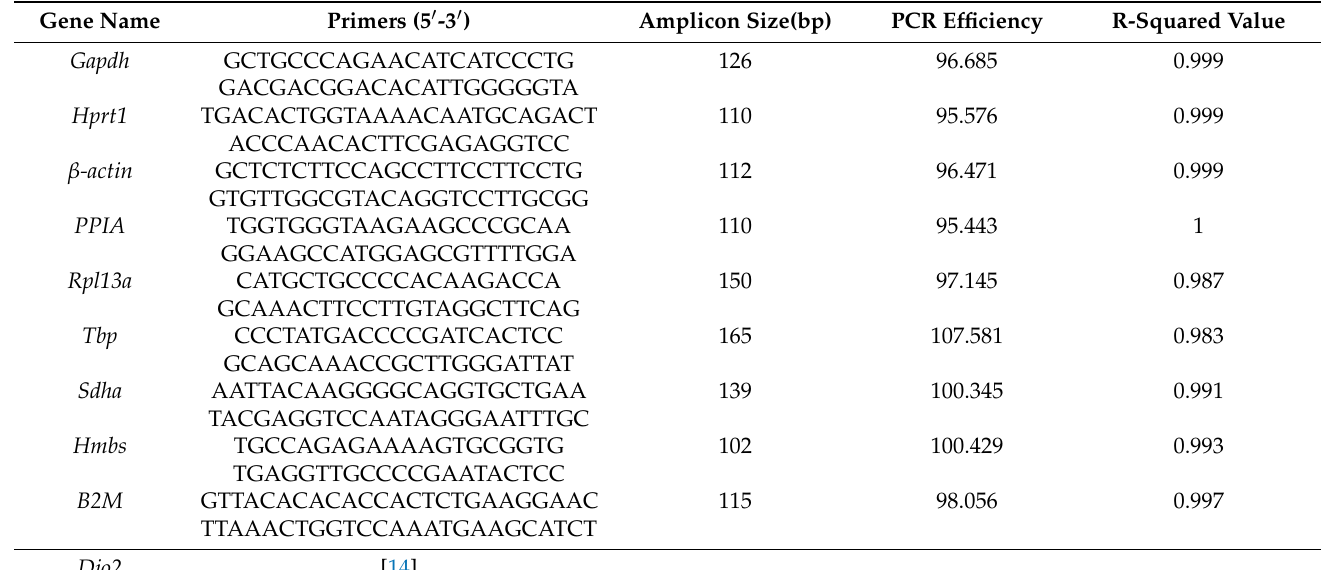
Table 2. Test of primer